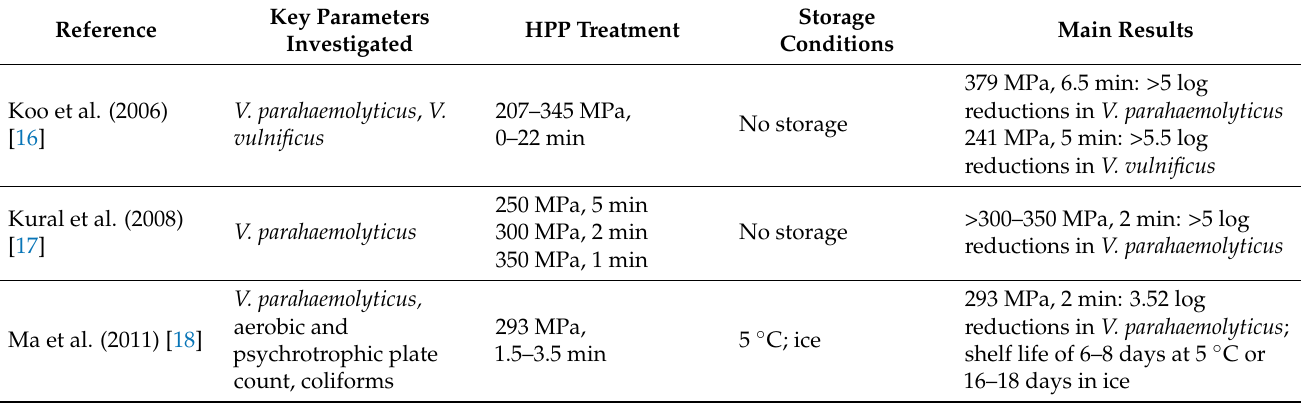
Table 1. Summary of the main results of published papers on the use of HPP to improve oyster